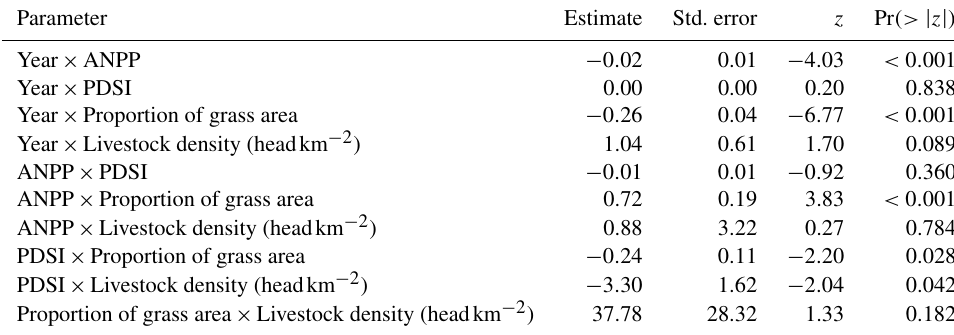
Table 2. Model parameters and associated p values. Parameter Estimate Std. error